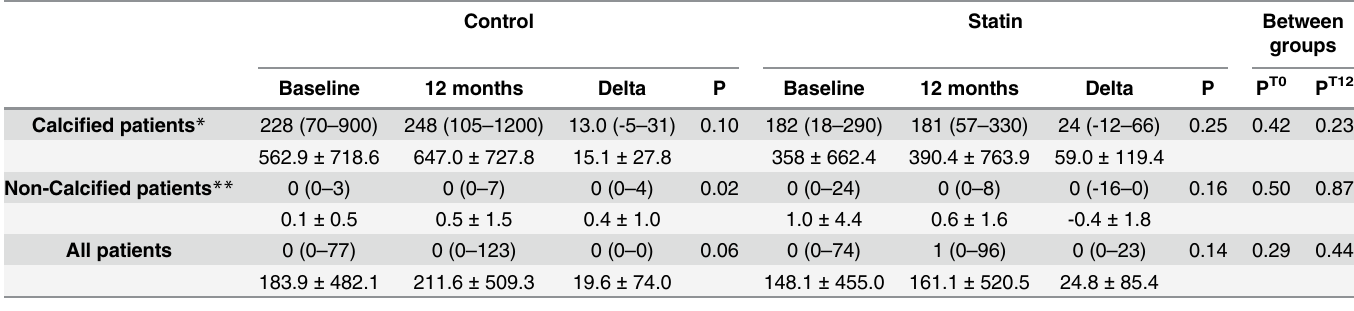
Table 3. Comparison of coronary calcification (CAC score — AU) in the statin and control groups, considering calcified ( (cid:1) 10 AU), non-calcified and all